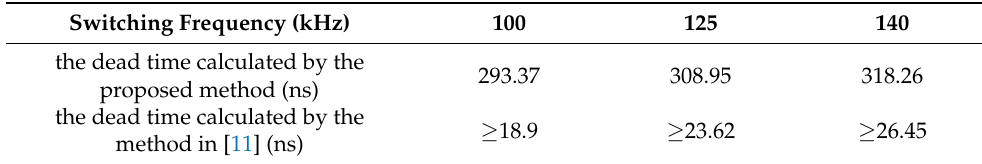
Table 3. Calculation results of dead time under different methods.